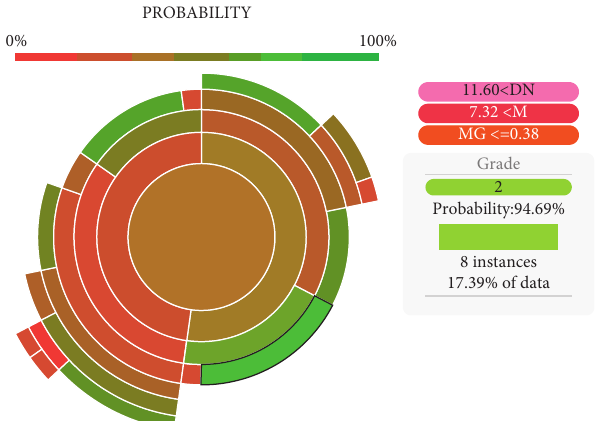
Figure 8: Prediction probability distribution of the decision tree model from the perspective of the sunburst chart.